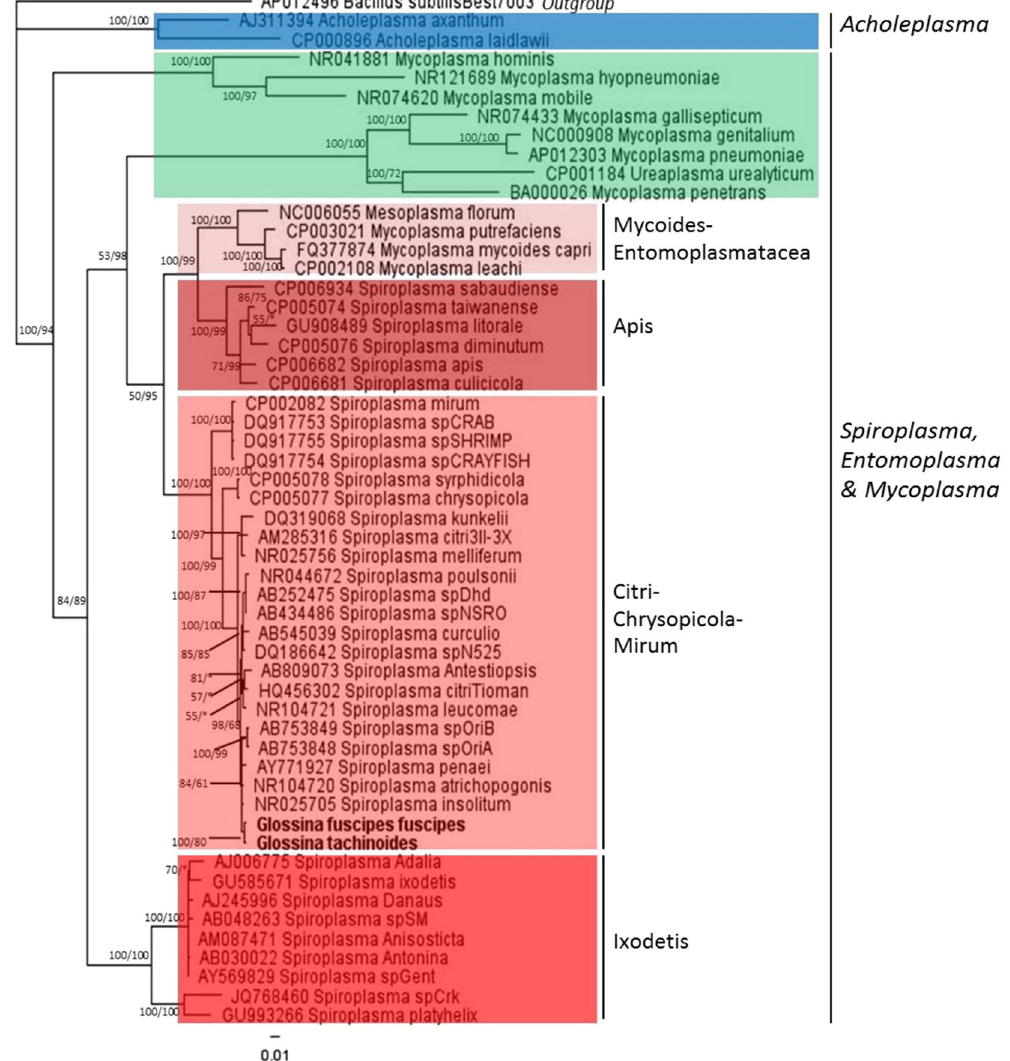
Figure 4. Bayesian inference phylogeny based on the 16S rRNA gene sequence: The topology resulting from the Maximum Likelihood (ML) method was similar. Bayesian posterior probabilities and ML bootstrap values based on 1000 replicates are given at each node, with the posterior probabilities given first followed by the ML bootstrap values (only values > 50% are indicated), respectively. Asterisks indicate support values lower than 50%. The Spiroplasma strains present in Gff and Gt are indicated in bold letters. For each Spiroplasma species the GenBank accession number is given to the left of the